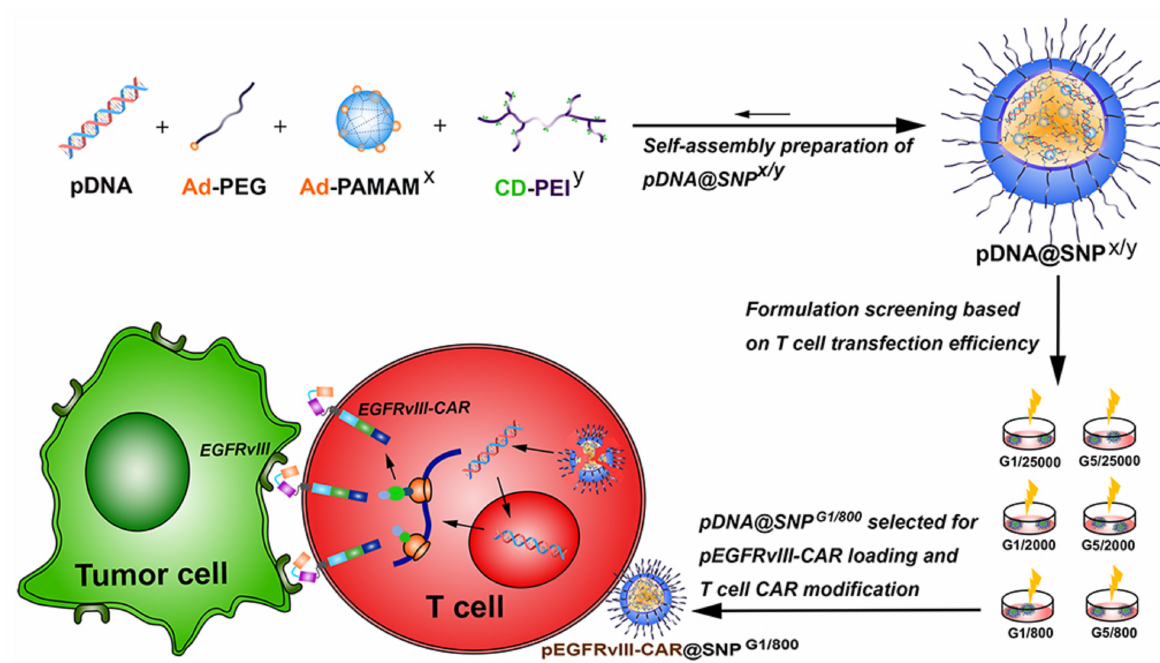
Figure 7. Schematic illustration of the preparation and formulation screening of pDNA@SNPs for pEGFRvIII-CAR loading and T cell CAR modification. Abbreviations: pDNA, plasmid DNA; Ad-PEG, adamantane-grafted poly(ethylene glycol); Ad-PAMAMx, adamantane-grafted polyamidoamine dendrimer (x: PAMAM dendrimer generation); CD-PEIy, cyclodextrin- grafted branched polyethylenimine (y: PEI molecular weight); SNPs, self-assembled nanoparticles; EGFRvIII, epidermal growth factor receptor variant III; CAR, chimeric antigen receptor; pEGFRvIII-CAR, epidermal growth factor receptor variant III-chimeric antigen receptor expression plasmid. With the permission of [153], copyright (2021) Dove Medical